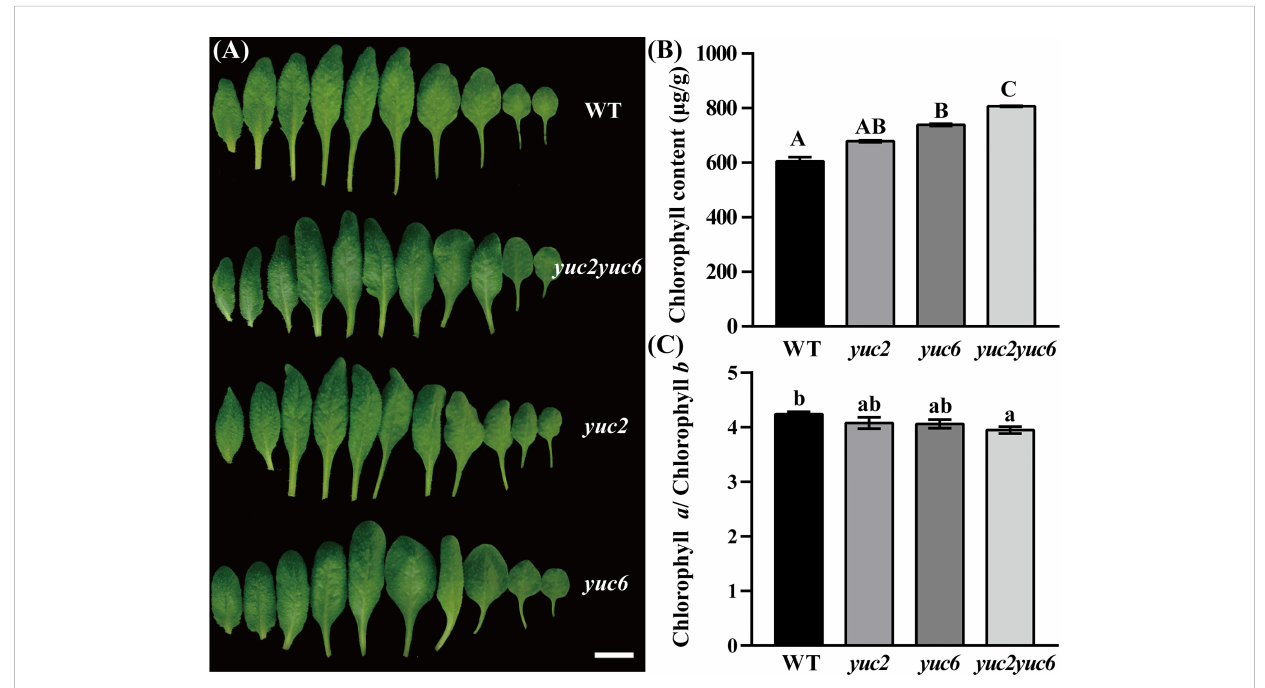
FIGURE 1 Phenotype of yuc2 yuc6 leaves. (A) Leaves of 4-weeks-old plant, bar = 1 cm. (B) Chlorophyll content in WT and mutants. (C) Ratio of chlorophyll a and b in WT and mutants. The capitals represent p value < 0.01, and the lowercases represent p value <